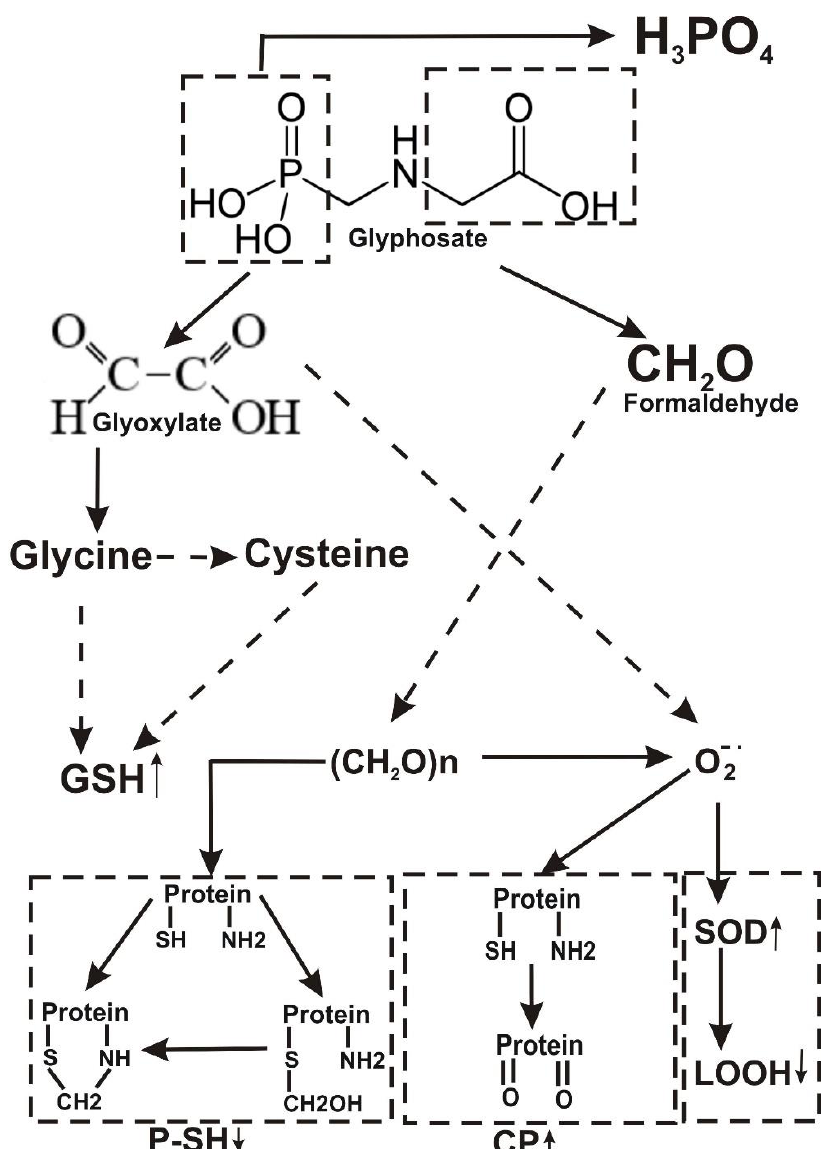
Figure 6: Hypothetical representation of mechanisms responsible for glyphosate-induced stress in Daphnia magna . CP, carbonyl protein; GSH, glutathione; P-SH, high molecular mass thiols; LOOH, lipid peroxides; SOD, superoxide